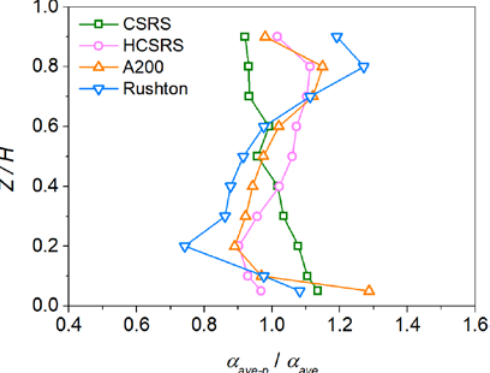
Figure 12. The distribution of solid volume fraction at different horizontal planes for the four types of agitators at the stirring speed of 400 rpm; ( a ) CSRS agitator; ( b ) HCSRS agitator; ( c ) A200 agitator; ( d ) Rushton agitator.